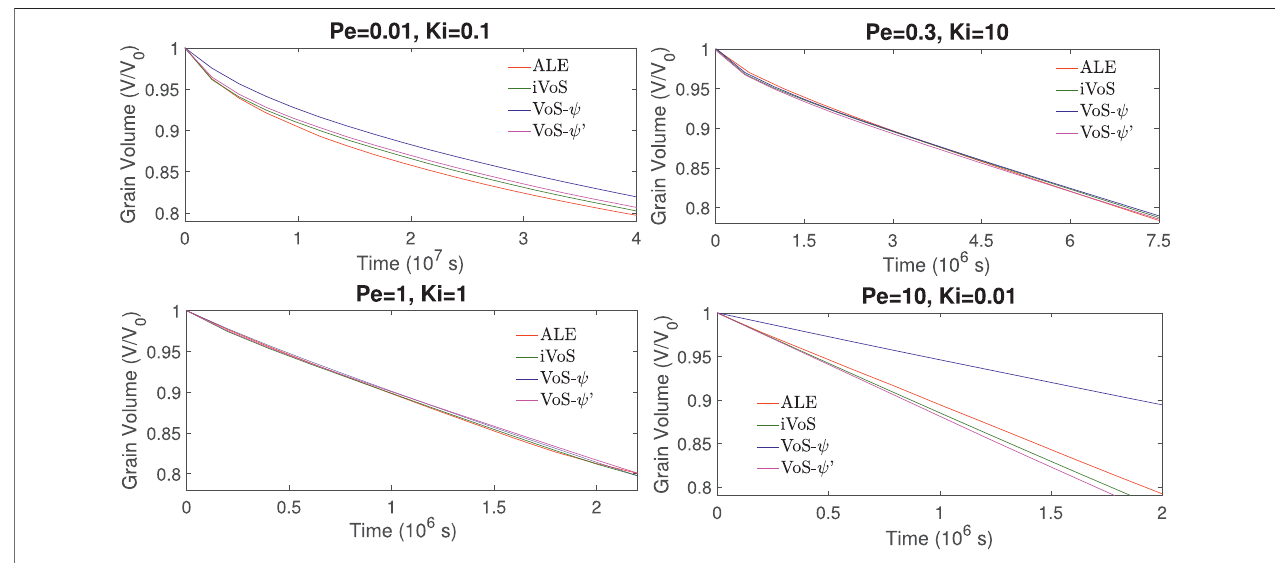
FIGURE 5 | Evolution of the solid volume during numerical simulation of dissolution in a 2D micromodel at four different regimes.